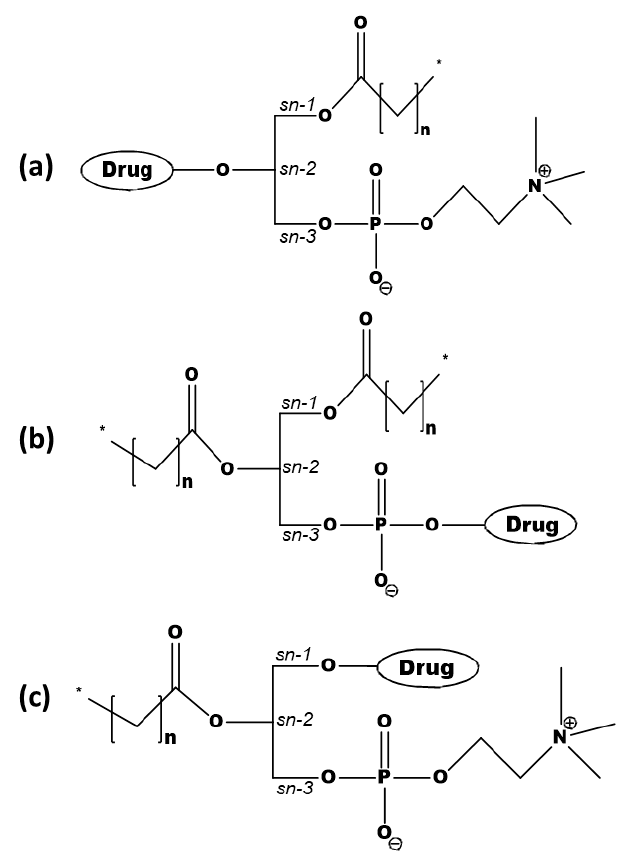
Figure 1. Prodrugs, with the active drug covalently attached to the ( a ) sn -2 position of the phospholipid (PL), ( b ) phosphate group, or ( c ) the sn -1 position of the PL.